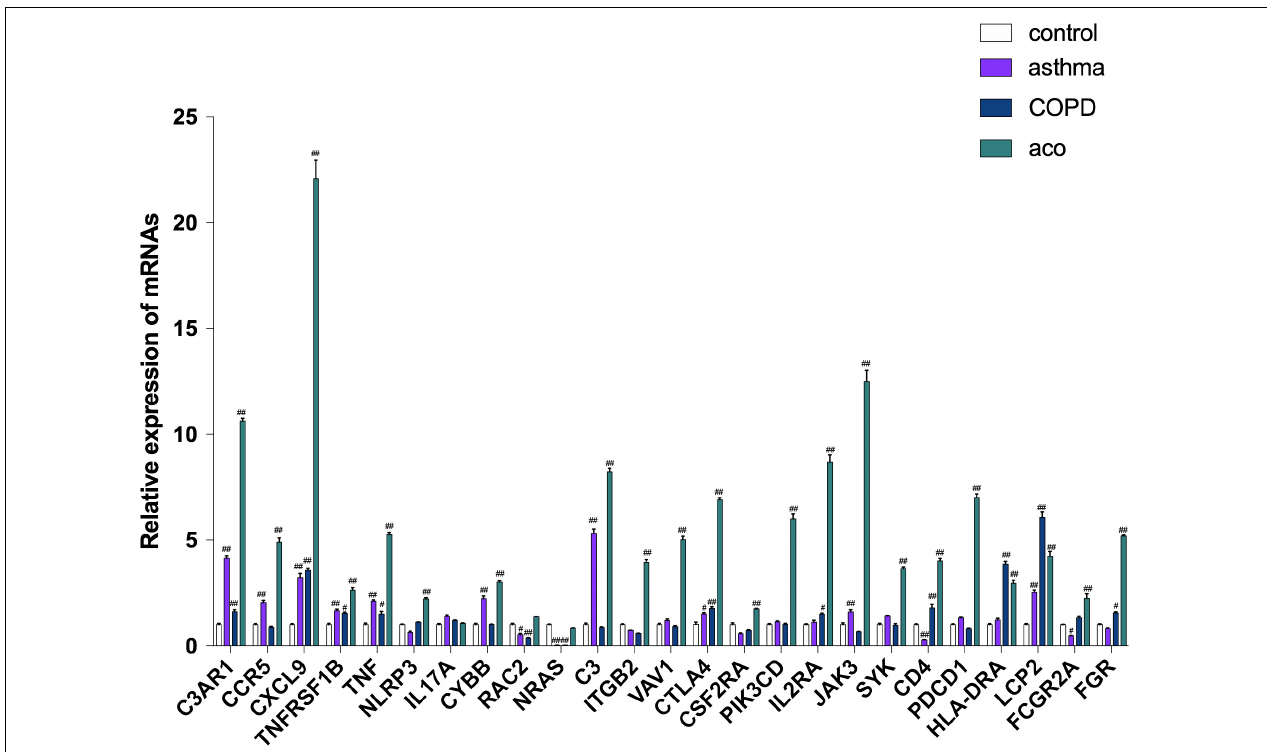
FIGURE 7 | Verification of key genes by using RT-PCR. Data were shown as mean ± SEM of three independent experiments. # P < 0.05 and ## P < 0.01 compared with the control